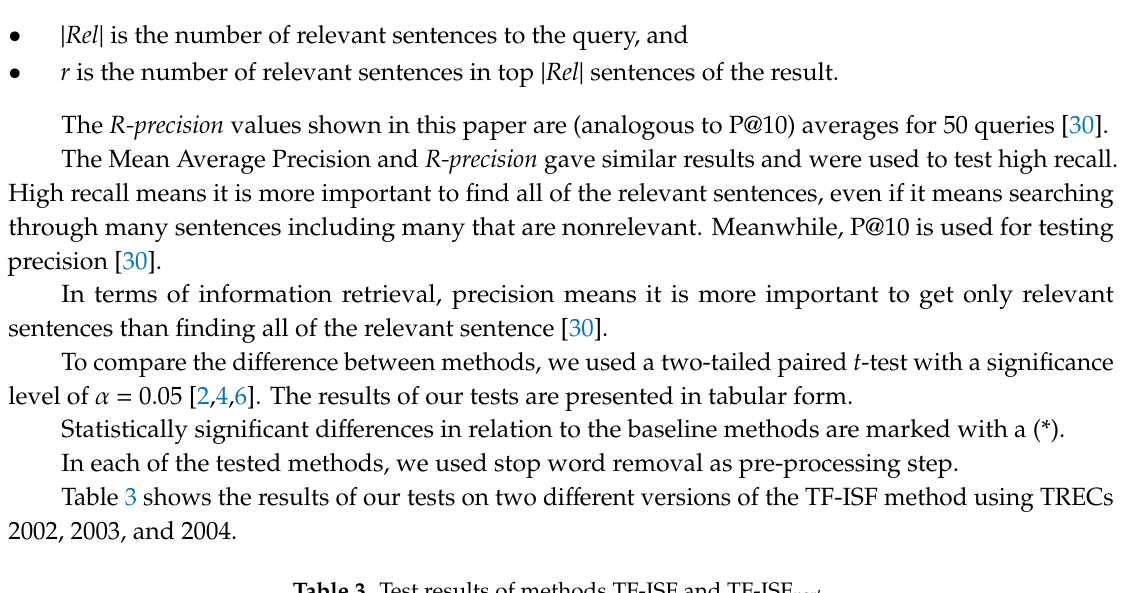
Table 3. Test results of methods TF-ISF and TF-ISF part . Data Collection Measures TF-ISF TF-ISF